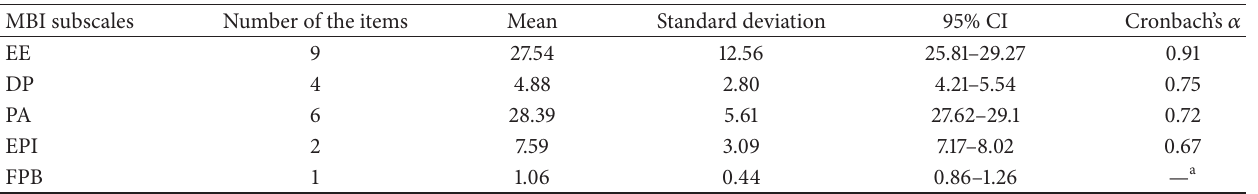
Table 4: Means, standard deviations, 95% confidence intervals, and internal consistency estimates on five-factor structure of the Maslach Burnout.